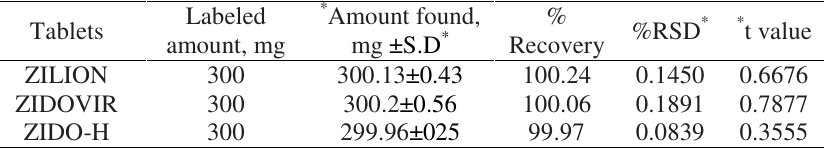
Table 2. Assay and recovery of zidovudine in tablet